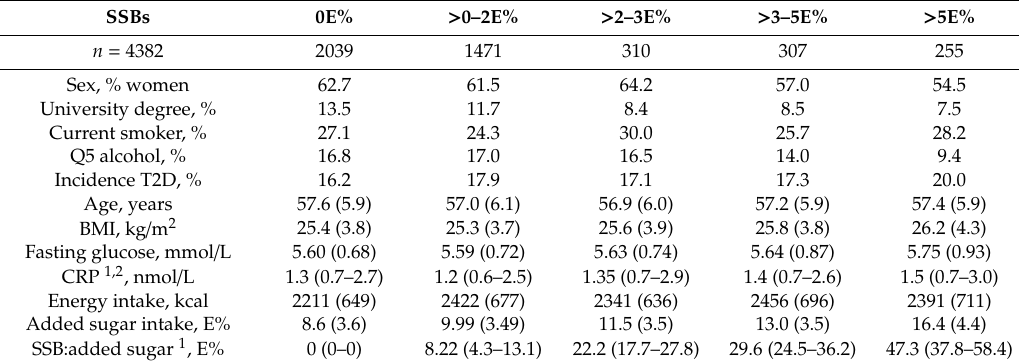
Table 2. Baseline characteristics of study participants across five categories of SSB